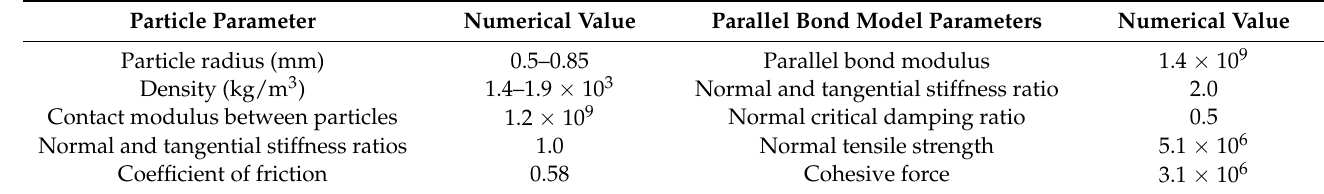
Table 3. Main parameters of PFC2D in the pull-out